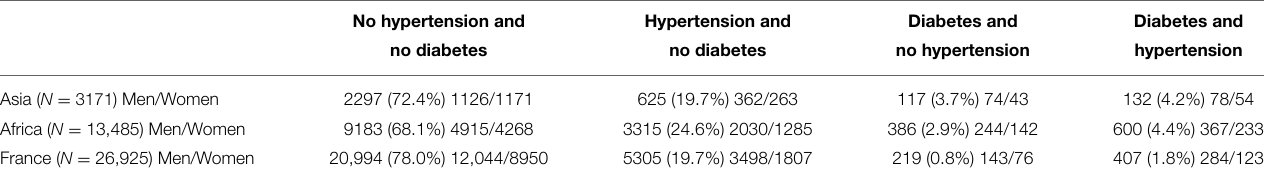
TABLE 1 | Prevalence of hypertension (N, %) and diabetes (N, %) in the overall population (men and women) according to country of birth (Asian country, African country, or France). No hypertension